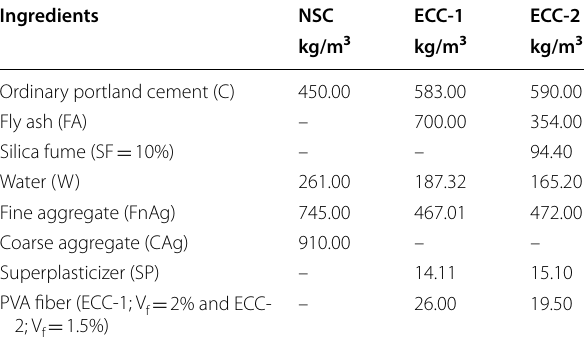
Table 2 Mix proportions of NSC and ECC.